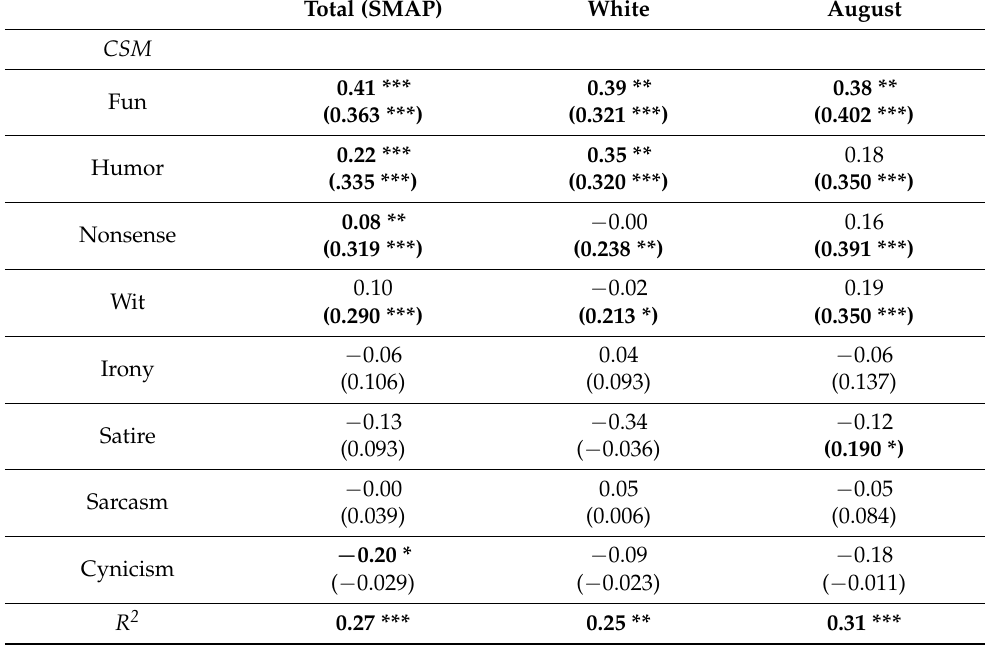
Table 3. Standardized betas and proportion explained variance for the regression analyses of SMAP on CSM as predictors in the whole sample and the Whiteface and the Auguste clowns (correlation in